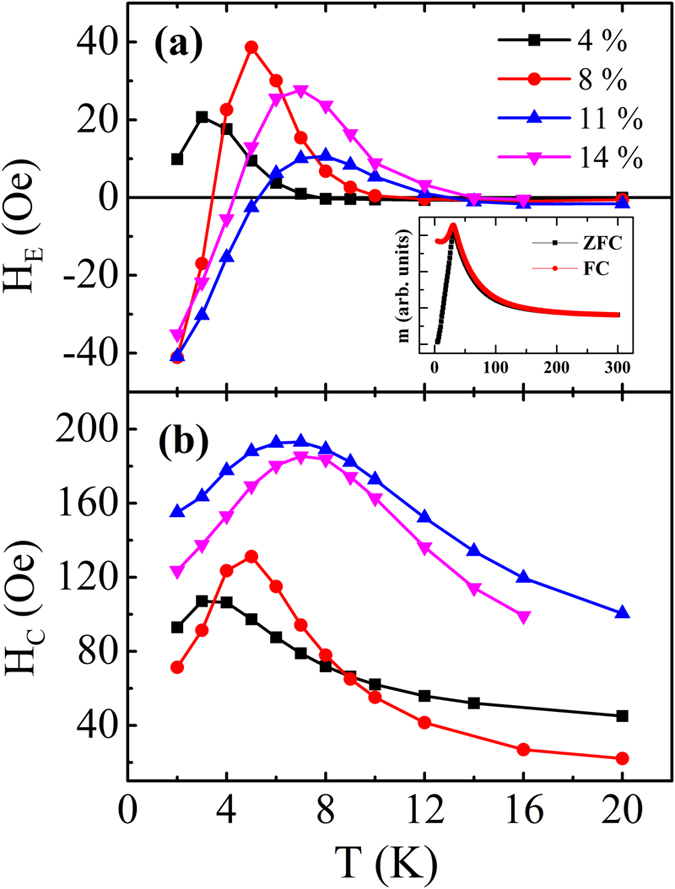
Temperature dependent HE (a) and HC (b) with a cooling field of HFC = 5 kOe for FexAu1 − x(50 nm)/FeNi(5 nm) bilayers with x = 4%, 8%, 11% and 14%.The inset shows the ZFC-FC magnetization curves for the Fe11Au89(50 nm) film under HFC = 50 Oe with T varying between 5 K to 300 K.